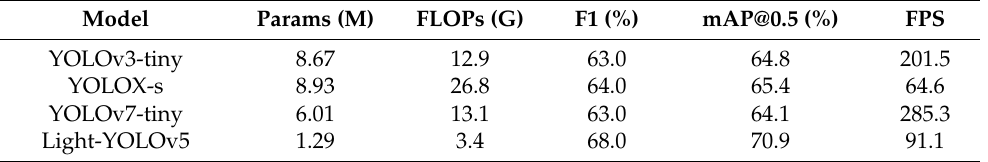
Table 5. Comparison of the results of the most advanced detectors at this